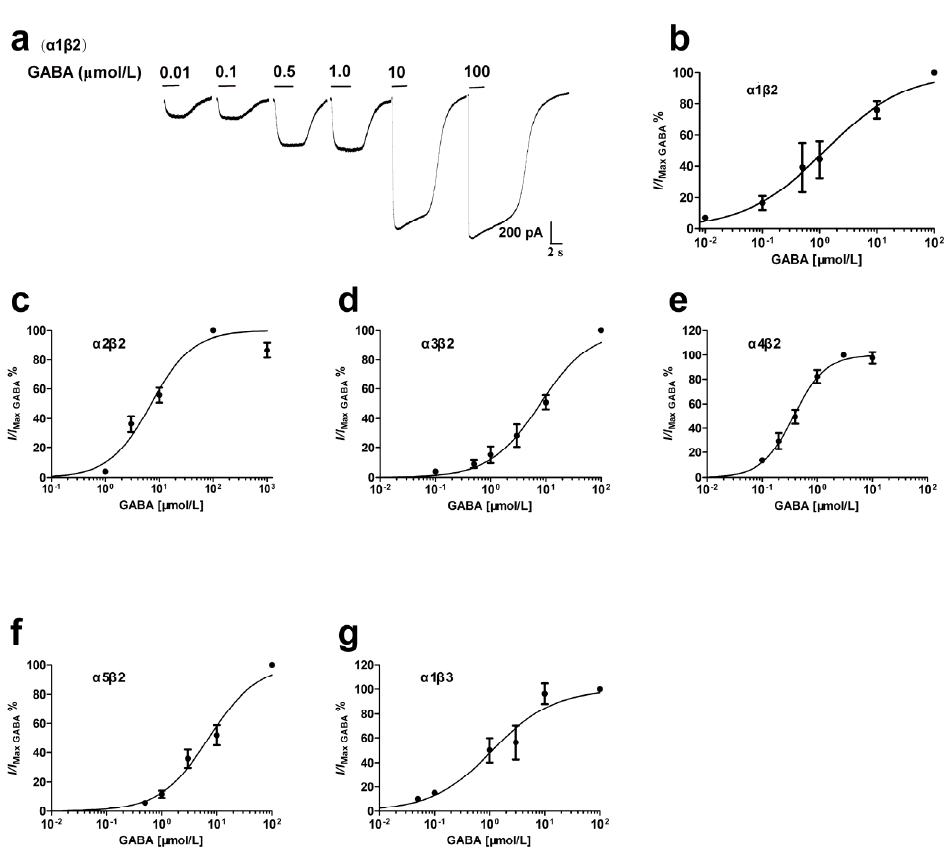
Figure 2. GABA concentration response relationships at recombinant αβ receptors. E ff ects of increasing